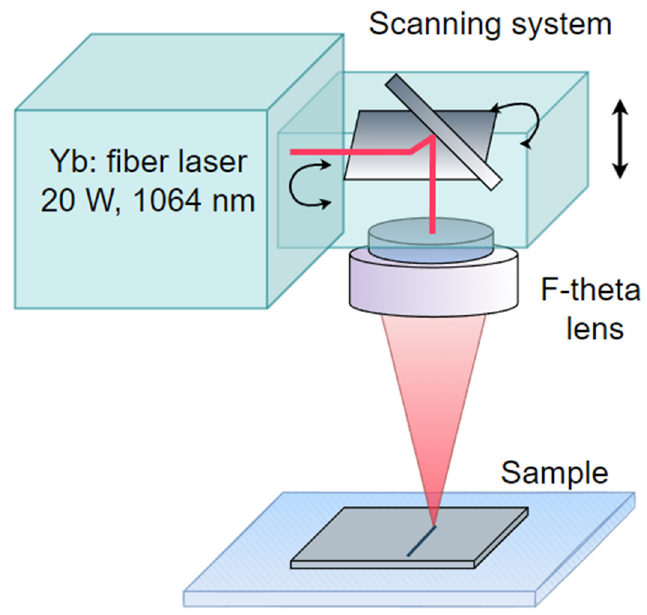
Figure 1. Diagram of an experimental setup scheme for laser modification of the structure of chalcogenide films using continuous radiation.